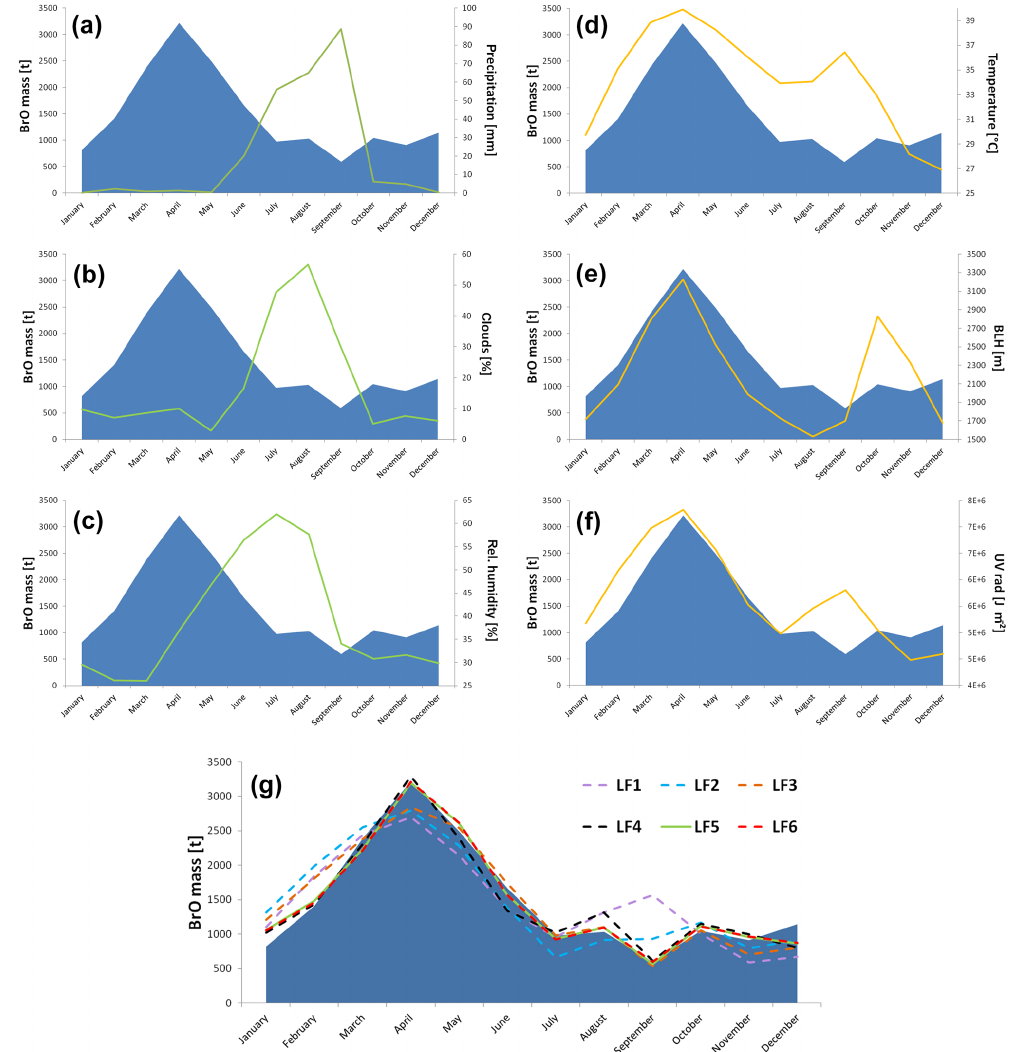
Figure 6. Monthly averaged variation of ECMWF meteorological parameters (thin lines) in comparison to the total BrO mass (blue area) over the Rann of Kutch during 2004–2014. The parameters can be divided into two groups by their seasonal behaviour (precipitation, cloud coverage and relative humidity are shown within the left column in green, a–c ; surface temperature, boundary layer height and UV radiation within the right column in orange, d–f ). The latter parameters correlate very well with the BrO mass during the first half-year, before a second maximum appears after the end of the monsoon. The results of a multilinear regression analysis suggest that a simple linear model (linear functions LF1–LF6, g ) can be used to adequately describe the annual variations (see text and Table 2 for further